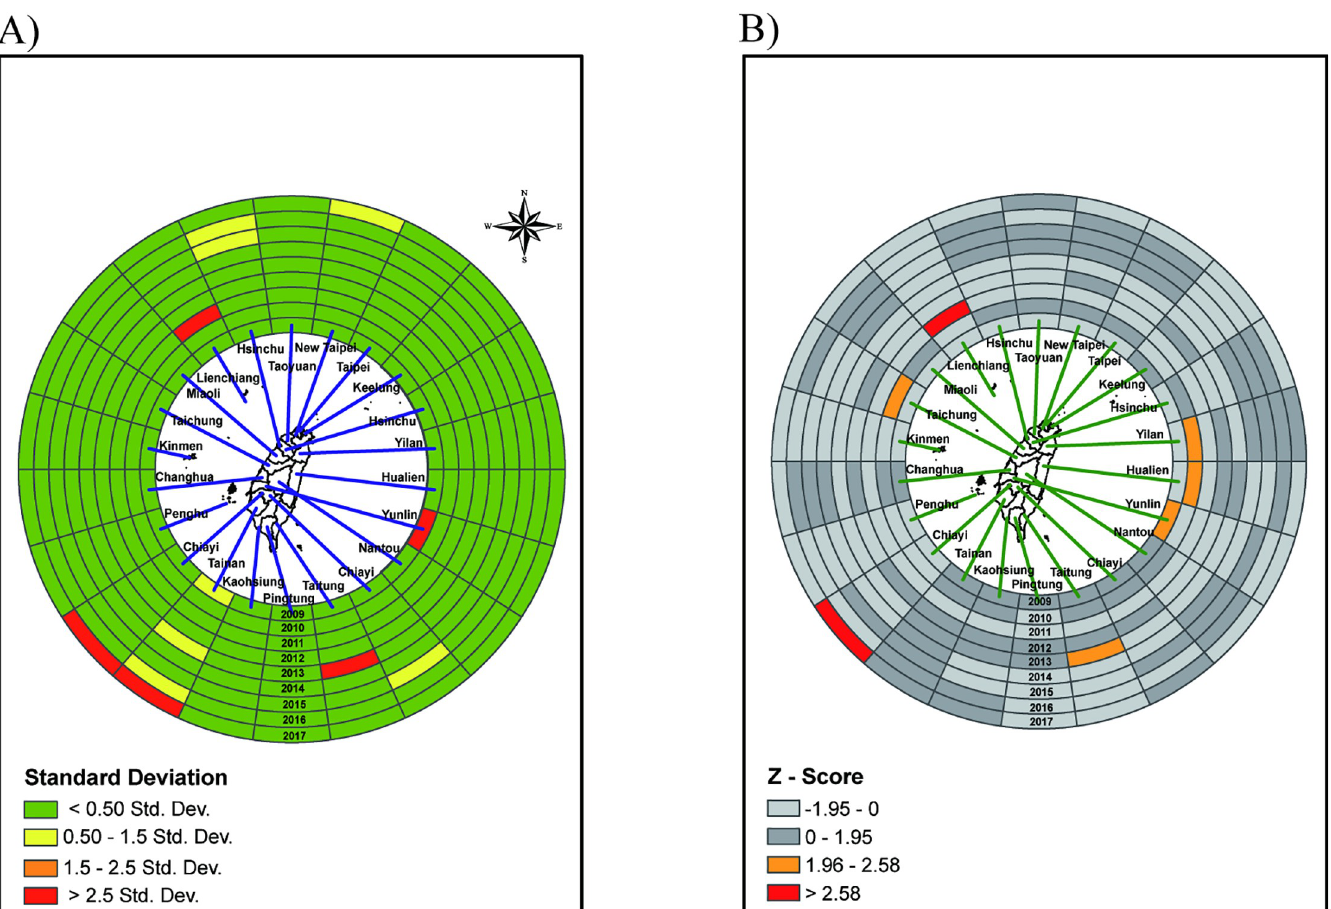
Fig 4. Ring map of hospitalization rate of scarlet fever in age group 3–4 years. (A) A Z score ring map from innermost in 2009 to outermost in 2017. (B) A ring map � without time of Z-scores by applying spatio-temporal G i